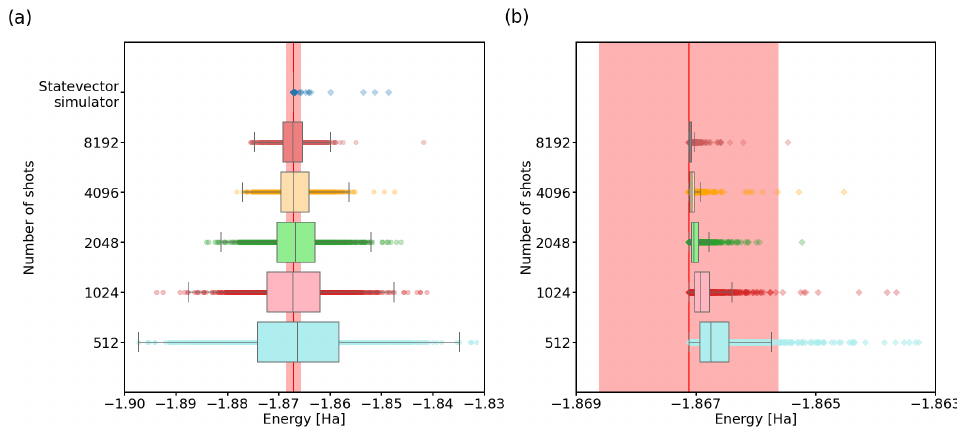
Figure 2. VQE energy estimate improvement with number of shots. We calculated the ground- state energy of H 2 using the VQE on a two-qubit system, the SPSA optimization algorithm with unrestricted maximum interations, and the R y variational circuit accompanied by linear entangle- ment. The red line represents the physical ground-state energy ( − 1.86712 Hartree) and the light-red background represents the chemical accuracy regime ( ± 0.0015 Hartree). ( a ) A boxplot of VQE results, with each box representing 1000 independent runs of the algorithm. ( b ) A statevector simulator calculation of the energies for the 1000 result states from ( a ). Note that all the energies are above the real ground-state energy.